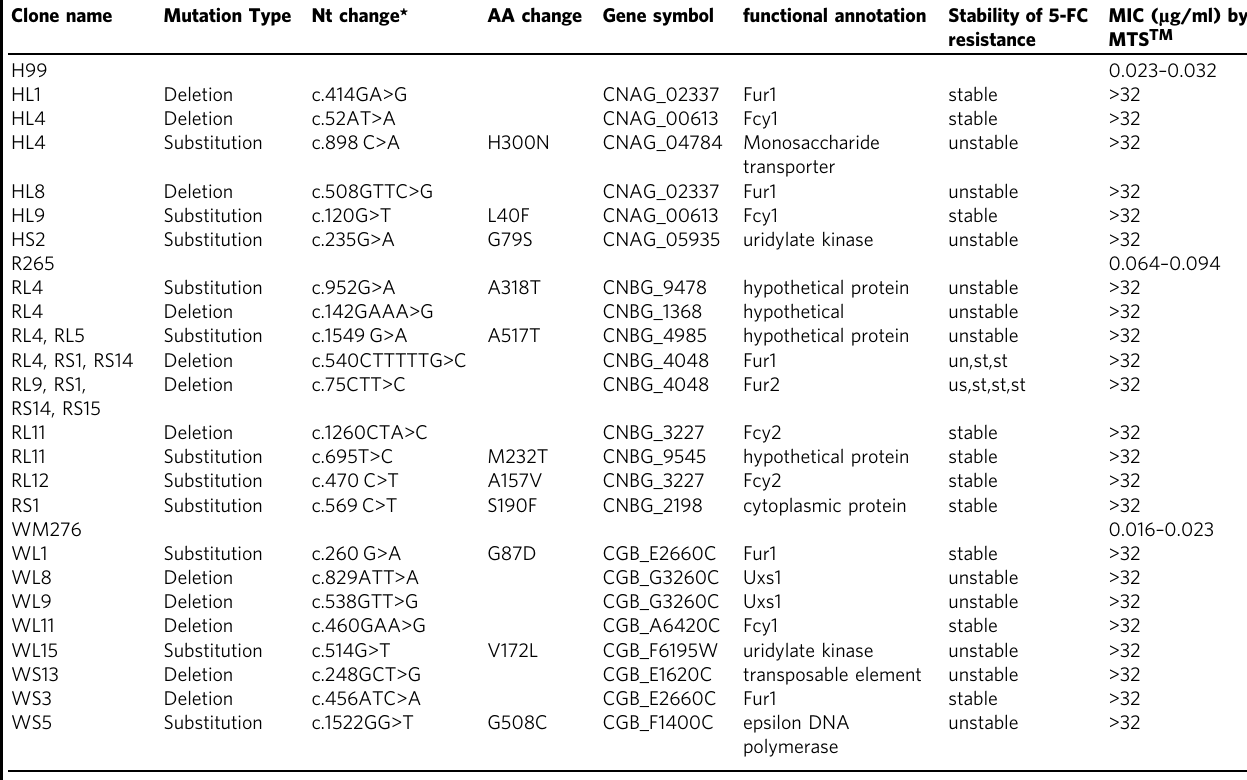
Table 1 Variants detected in the 5-FC resistance